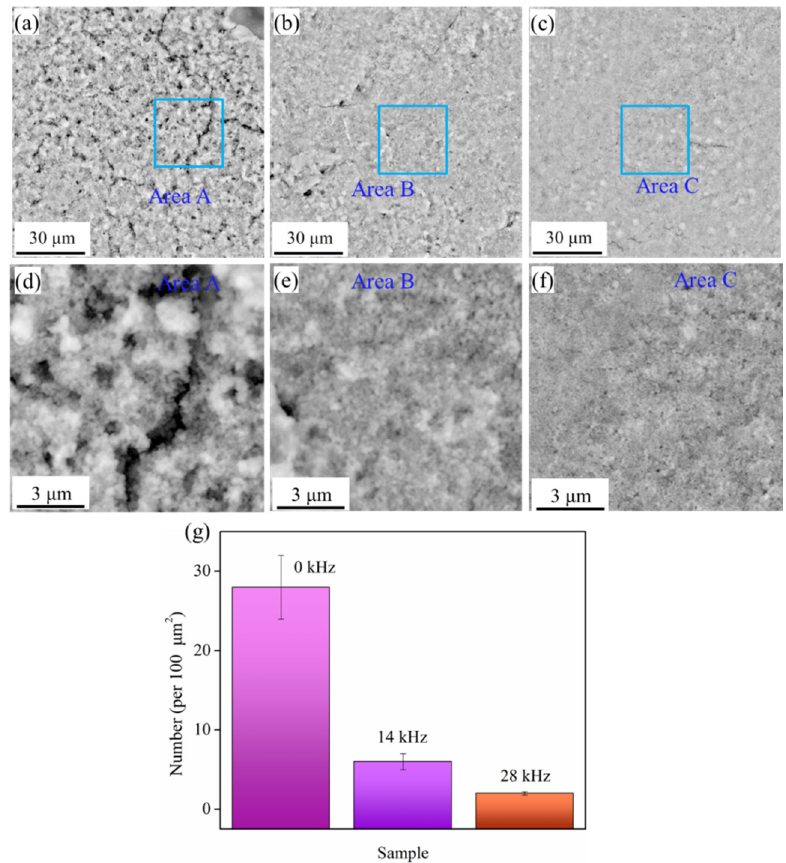
Figure 2. Morphologies of Mg alloy surfaces of ultrasonically treated fluoride coating at the frequency of ( a ) 0, ( b ) 14 and ( c ) 28 kHz, respectively, ( d–f ) enlarged images of area A, B, C, respectively, and ( g ) the number of pores per 100 μ m 2 .